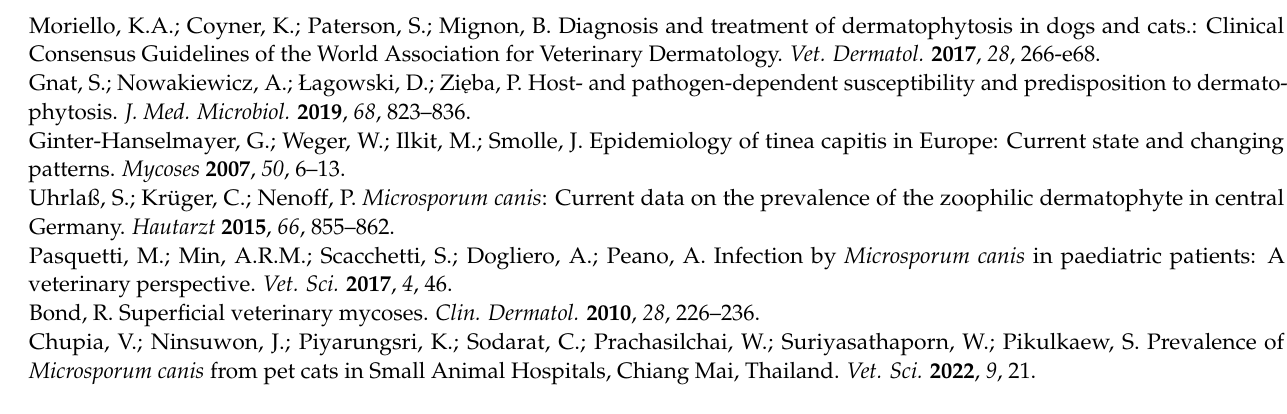
Figure S2: Phylogenetic tree analysis of Microsporum canis based on nucleotide sequences from a 720 bp fragment of ITS1-5.8S-ITS2 using the neighbor-joining method. Sequences from this study are marked with stars; Figure S3: Microscopic appearance of Microsporum canis biofilm classified as strong (a), moderate (b), and weak (c) biofilm producers after 72 h incubation (40 ×